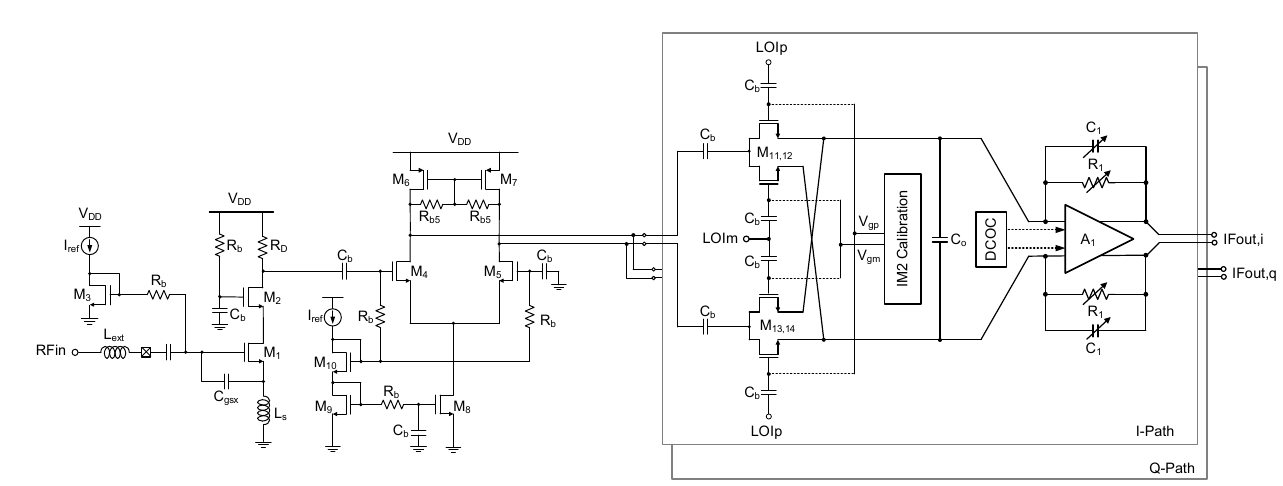
Figure 5. Circuit schematic of the RF front end.